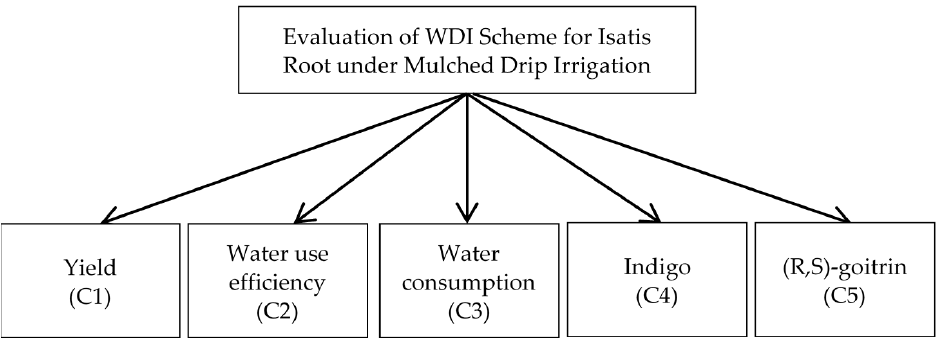
Figure 1. Hierarchical structure diagram.